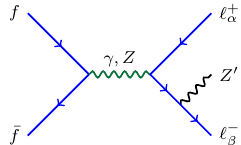
and red shaded regions are excluded by τ → µ Z (cid:48) , muon g − 2 discrepancy at the 5 σ C.L., and τ → µν ¯ ν . The purple and black dashed lines are, respectively, the limits from the LEP Z -pole data and the LHC W data. See text for more details. Figure from Ref. [215].